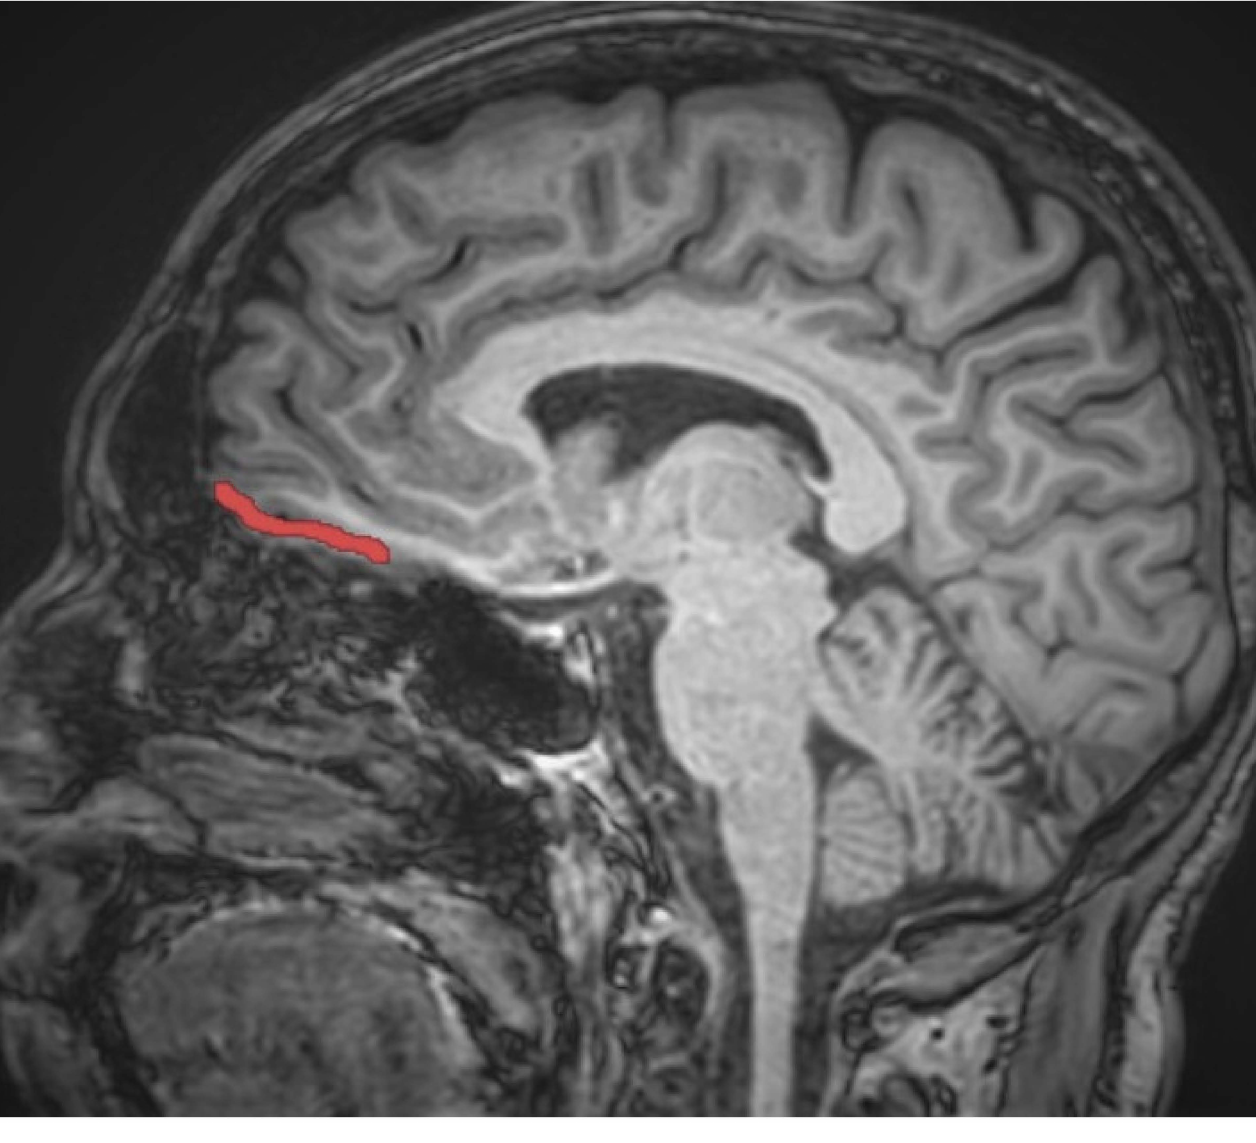
Figure 2. Sample cortical thickness measure for the